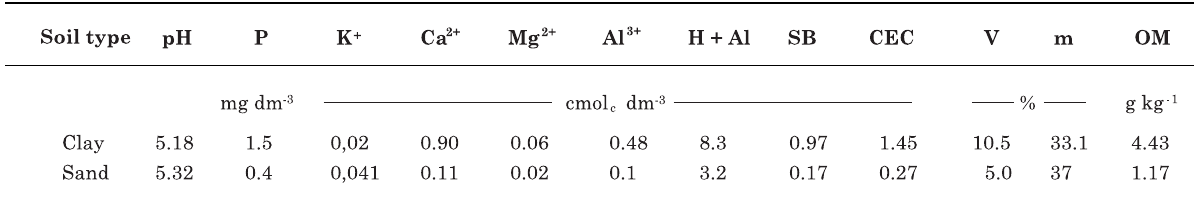
Table 1. Chemical characterization of the soil samples